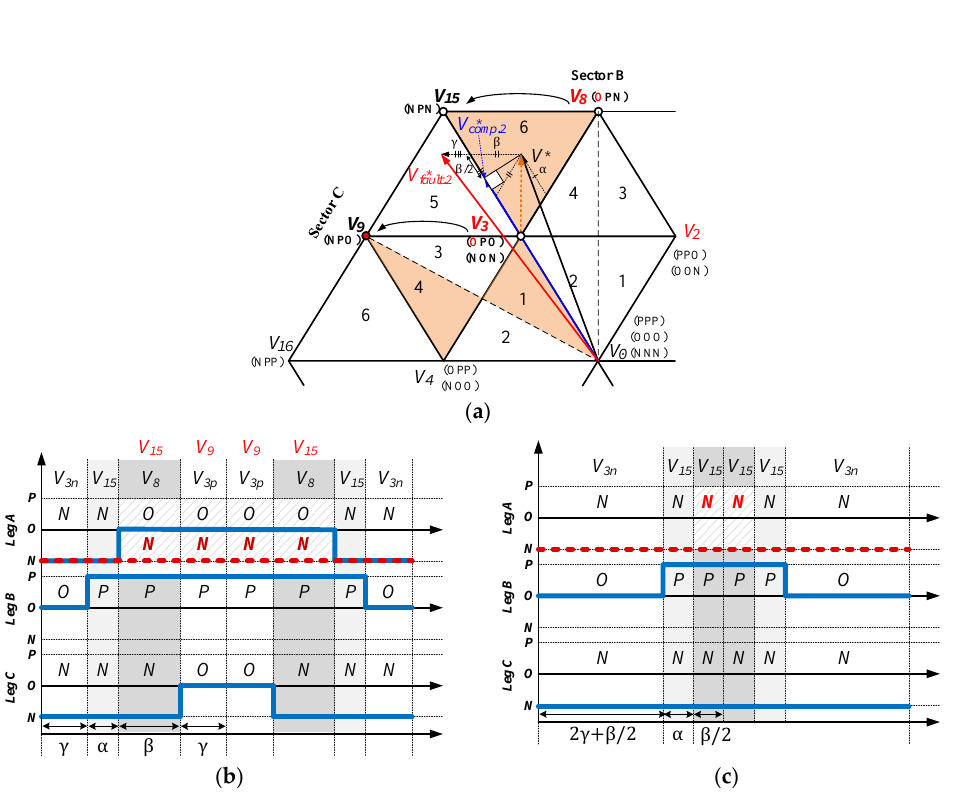
Figure 9. Reference voltage and switching patterns under the fault case 2. ( a ) Distortion and compensation of the reference voltage; ( b ) Switching pattern under the fault condition; ( c ) Switching pattern with the proposed fault-tolerant control